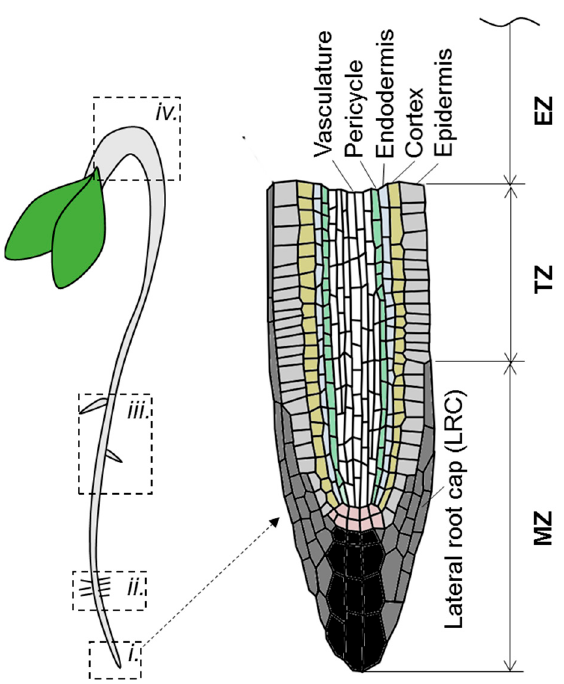
Figure 3. Schematic representation of Arabidopsis seedling structure. On the left panel the root top ( i. ), root hair forming region ( ii. ), the zone of mature root ( iii. ) and apical hook ( iv. ) are highlighted. On the right panel the root tip structure is detailed. MZ—meristematic zone; TZ—transition zone; EZ—elongation zone.